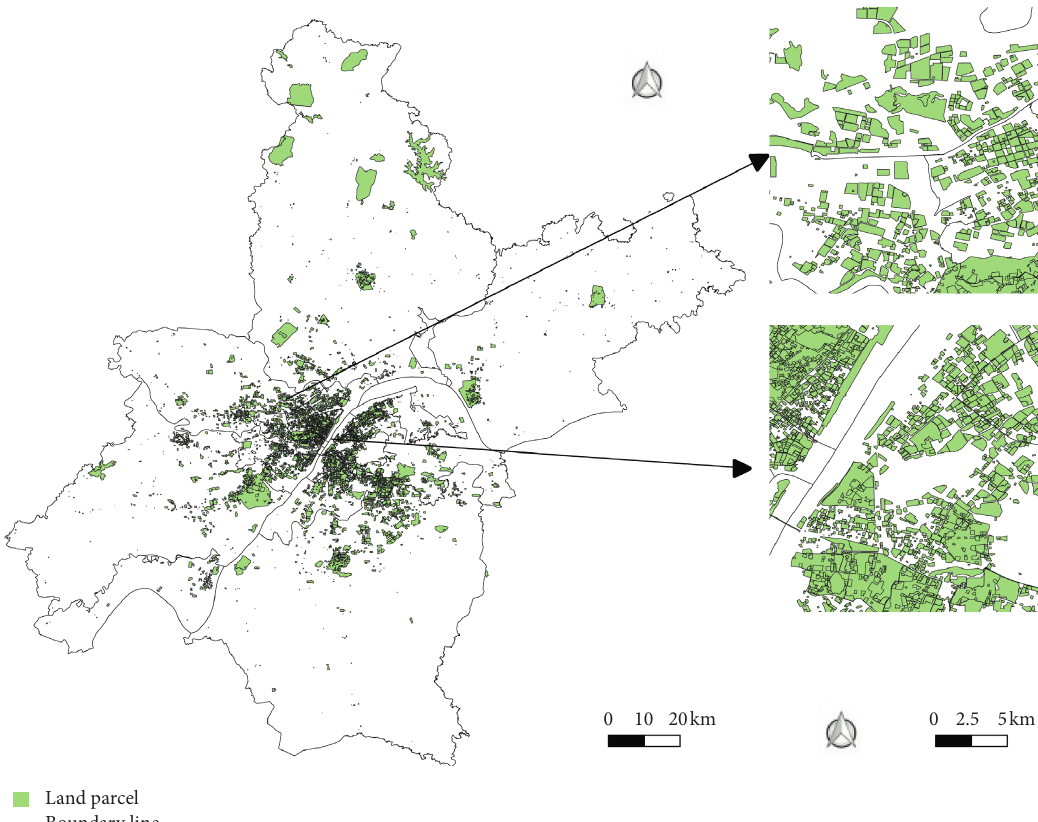
Figure 3: Spatial distribution of land parcels in Wuhan (the green shapes represent land